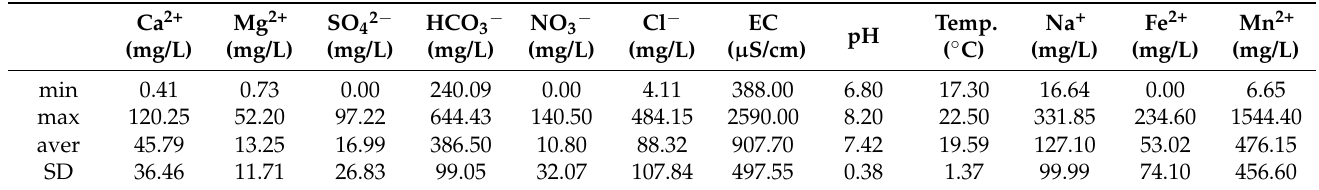
Table 2. Statistical analysis of some of the major chemical constituents from groundwater samples (May 2019) (confined aquifer).